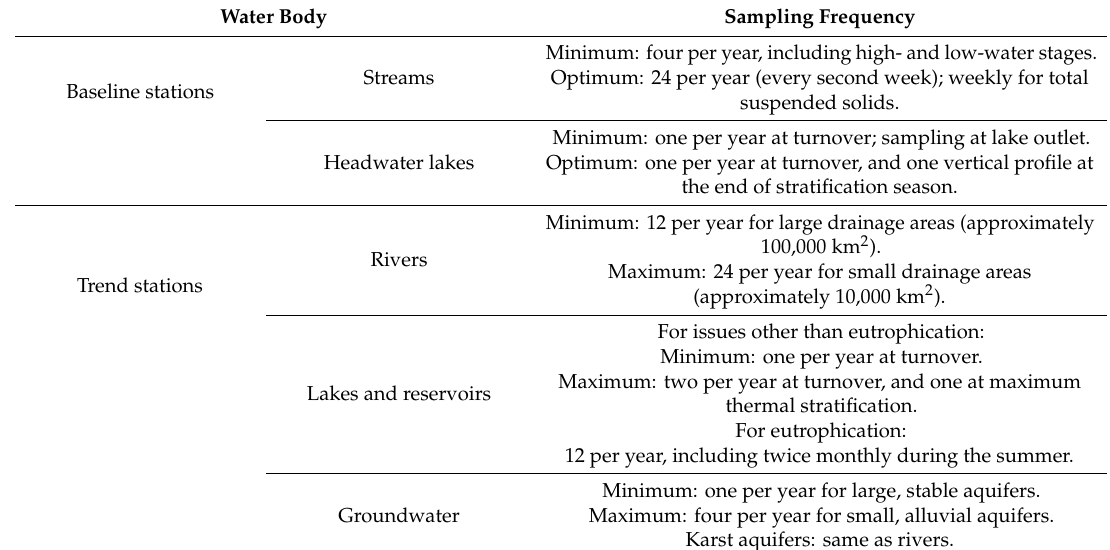
Table 1. Sampling frequency for Global Environment Monitoring System for freshwater (GEMS / WATER) stations